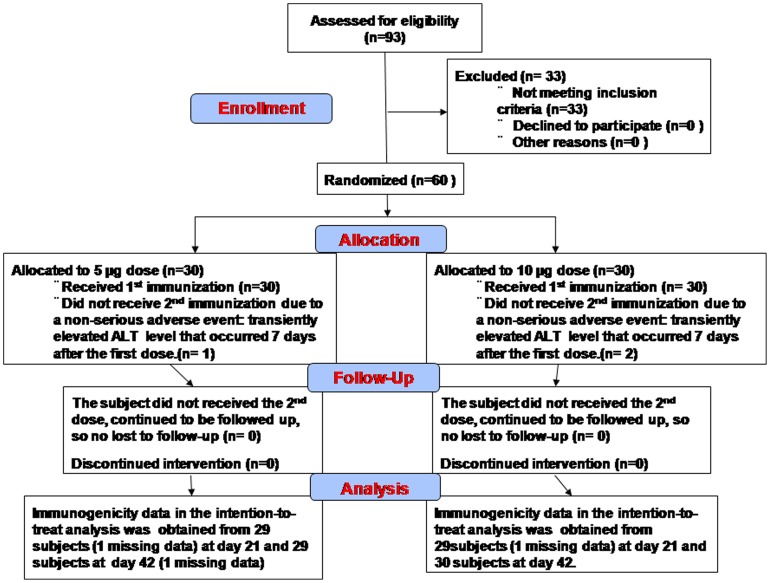
The CONSORT flowchart of EV71vac phase 1 clinical trial.The detail of volunteer enrollment is now fully described in our previous report [24].